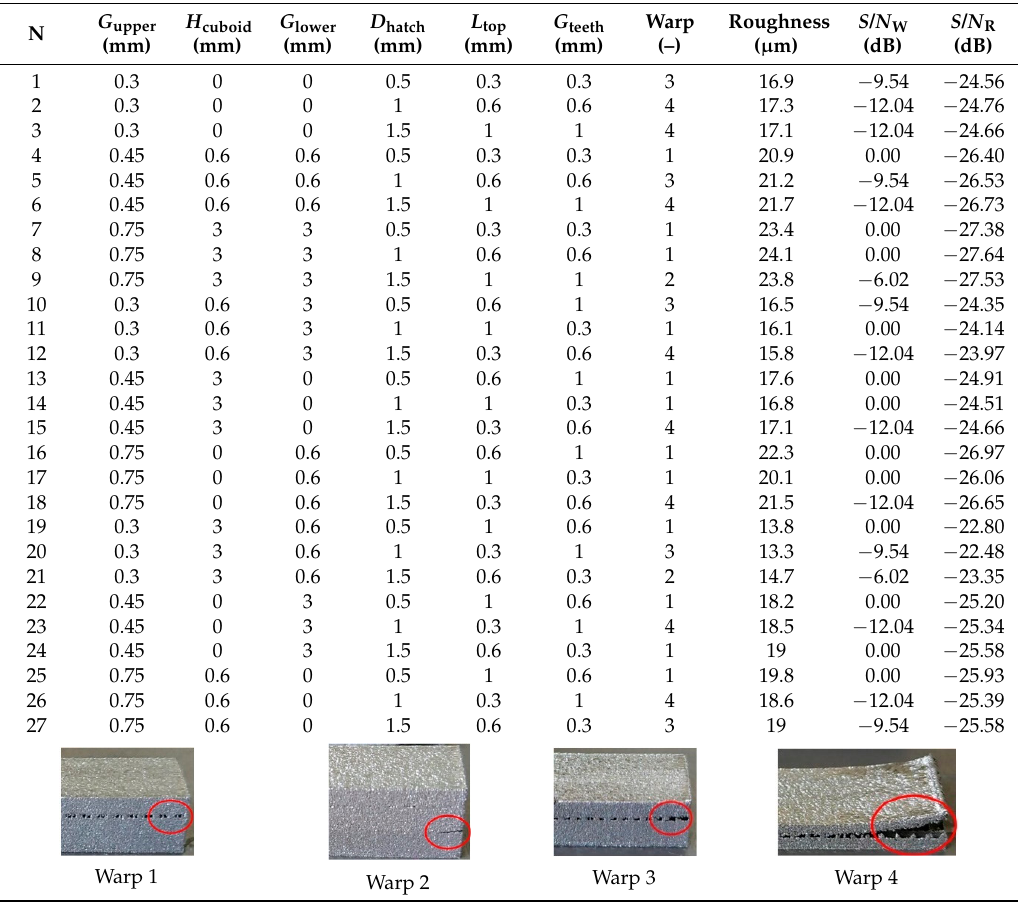
Table 4. Design of experiments and results.